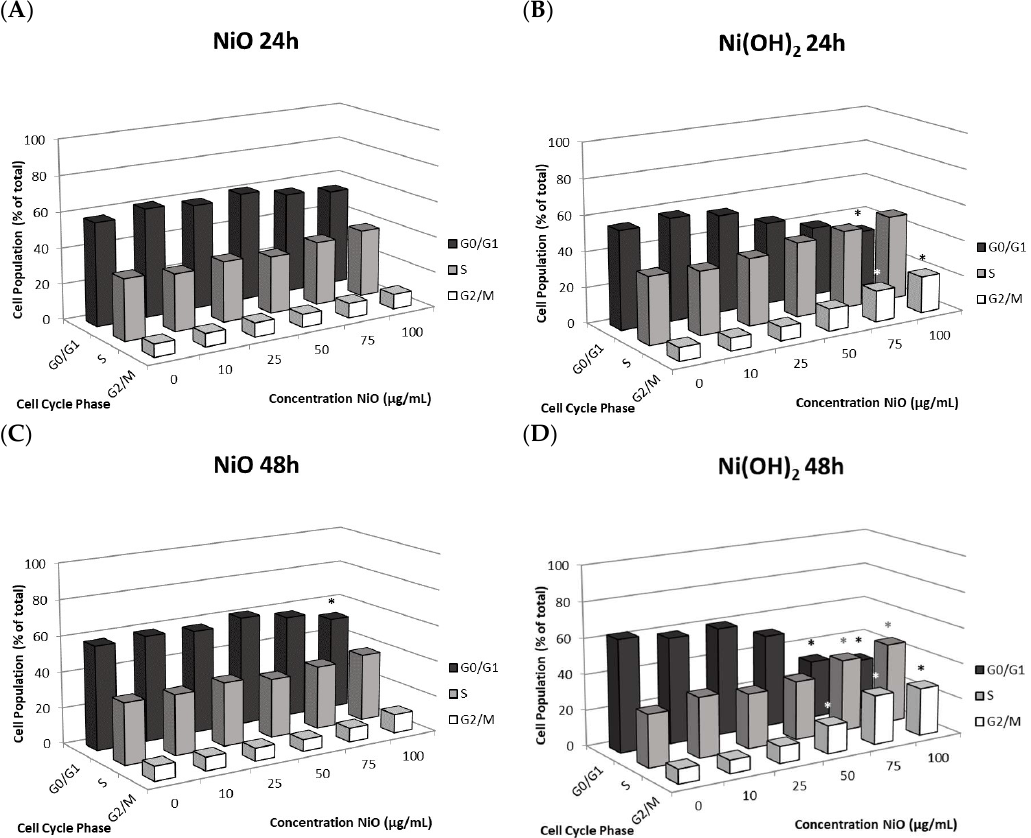
Figure 10. Flow cytometer analysis of cell cycle phase distribution of A549 cells. Analysis was measured after exposure to various concentrations of nanoparticle at ( A ) 24 h NiO, ( B ) 24 h Ni(OH) 2 , ( C ) 48h NiO, and ( D ) 48h Ni(OH) 2 , * p < 0.05 compared to each respective control using a one-way ANOVA with a Dunnett comparison. Values are expressed as the mean ± SD from three independent experiments.